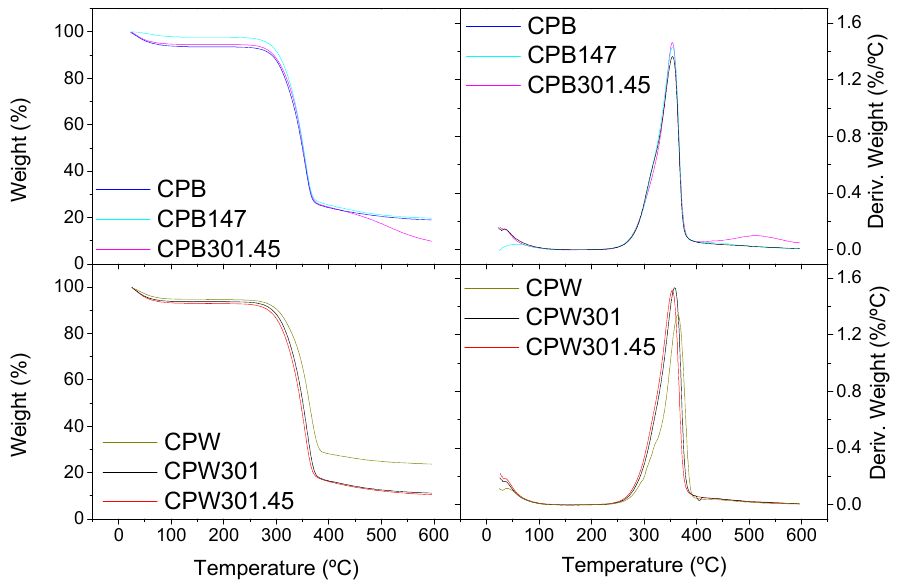
Table 2. Characteristic thermogravimetric analysis (TGA) parameters of the cellulose pulps studied. Sample